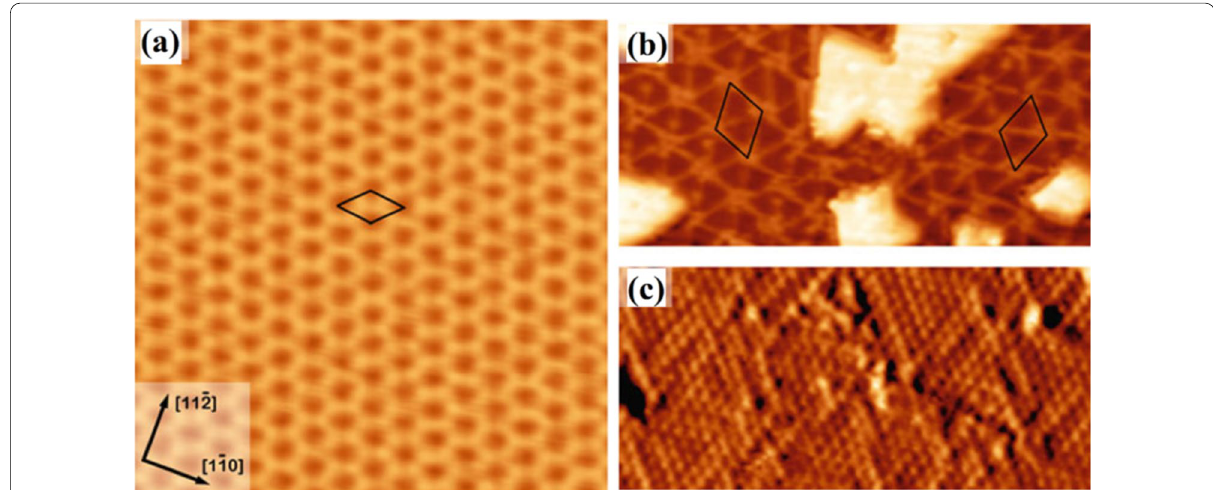
Fig. 3 STM image of a the honeycomb Ti 2 O 3 structure, and b pinwheel TiO monolayer grown on Au (111), and c atomically resolved STM image of pinwheel structures on Au (111). Reproduced with permission from